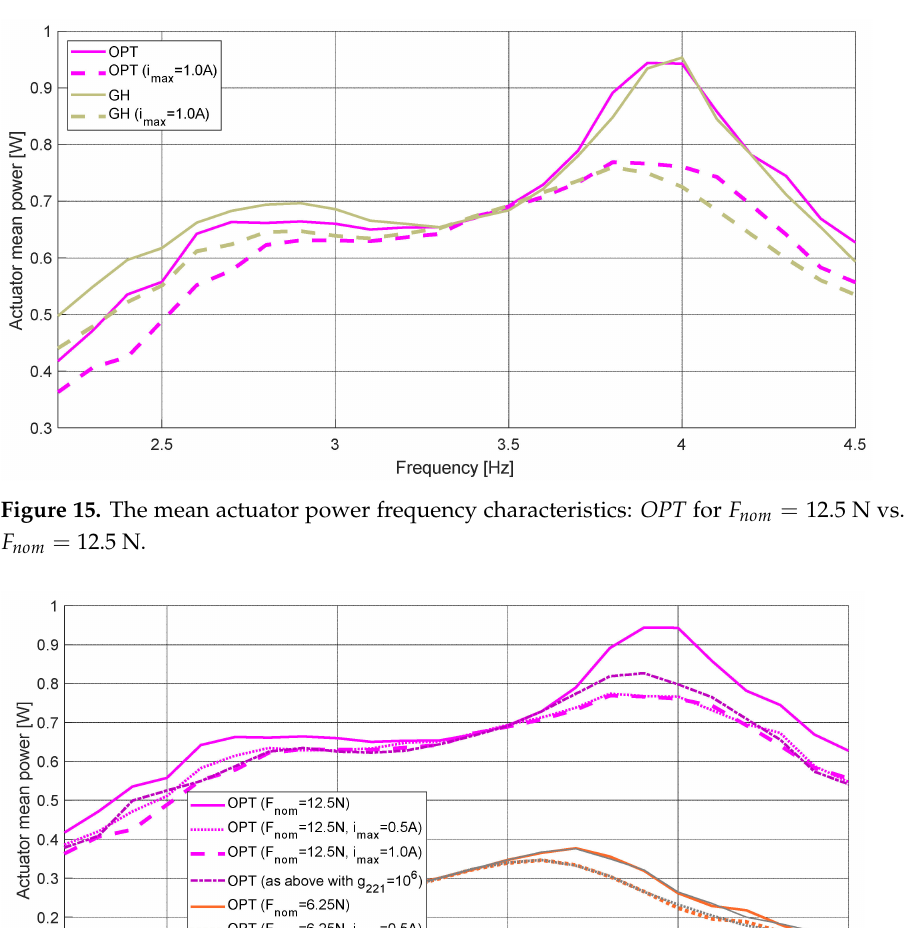
Figure 14. The maximum MR damper force frequency characteristics: OPT for different i max and g 23 values, and F nom = 12.5 N.